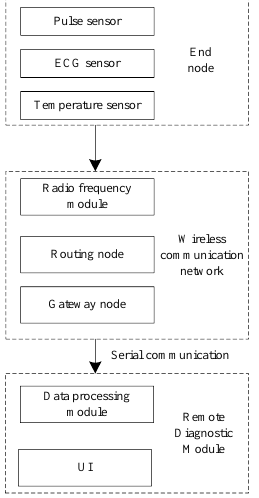
Figure 1. Overall structure of the system